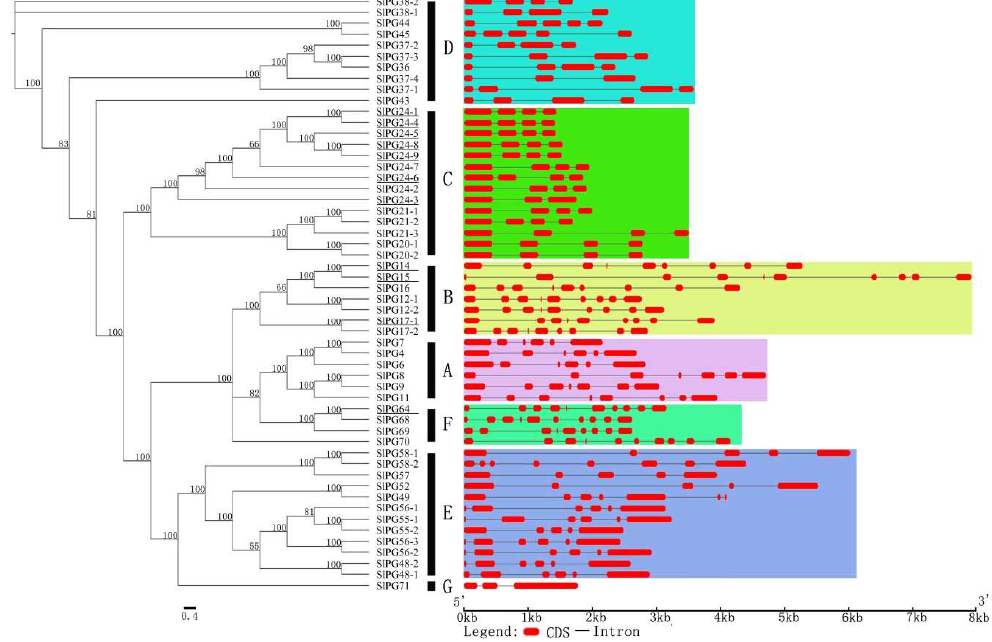
Figure 3. Phylogenetic analysis and intron/exon organization of tomato PG genes. Left part indicates the phylogenetic tree of tomato PG genes constructed based on the amino acid sequences. Different clades are named for their closest corresponding clades in previous studies on the evolution of PGs [12]. The SlPGs that have been reported by previous studies are indicated with underlines. Right part illustrates the intron/exon configurations of the corresponding tomato PG genes. The red rounded rectangle indicates the exon, and the line indicates the intron. Gene structures of PG genes in different clades are shaded by different colors.